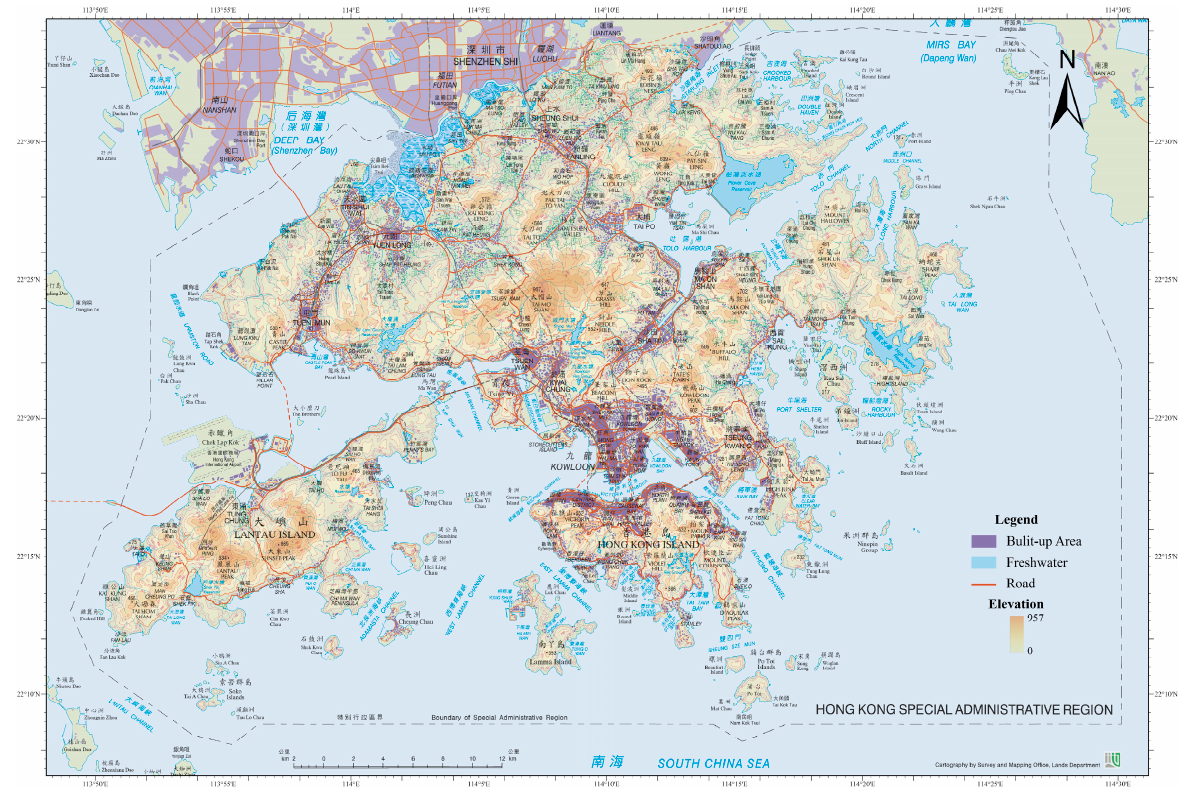
Figure 1. Schematic diagram of the study area (original image source: Survey and Mapping Office, Lands Department of the Hong Kong Special Administrative Region).